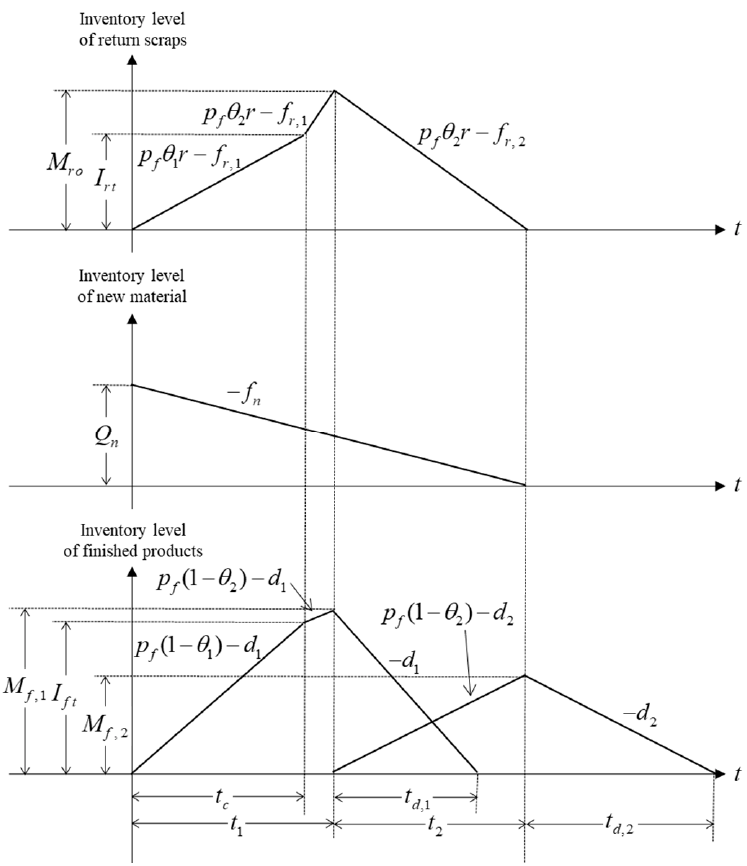
Figure 3. Graph of inventory levels for scrap returns, material, and finished product.